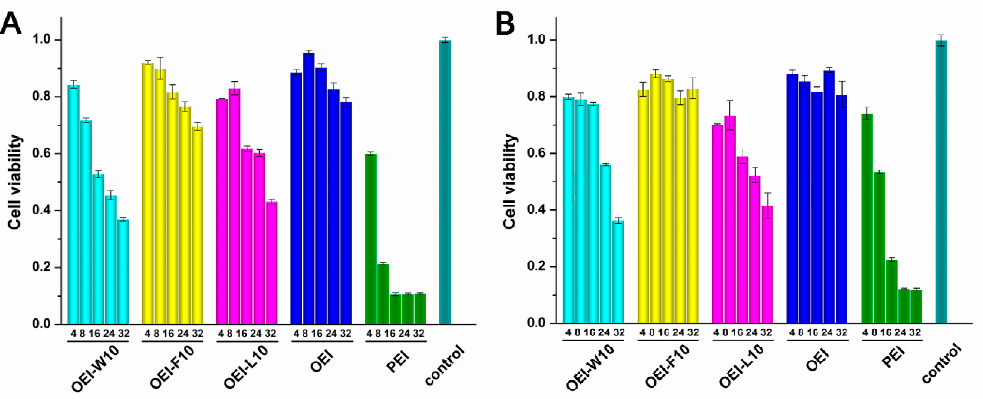
Figure 8. Cytotoxicity of polyplexes at various weight ratios in HEK293 ( A ) and HeLa cells ( B ).